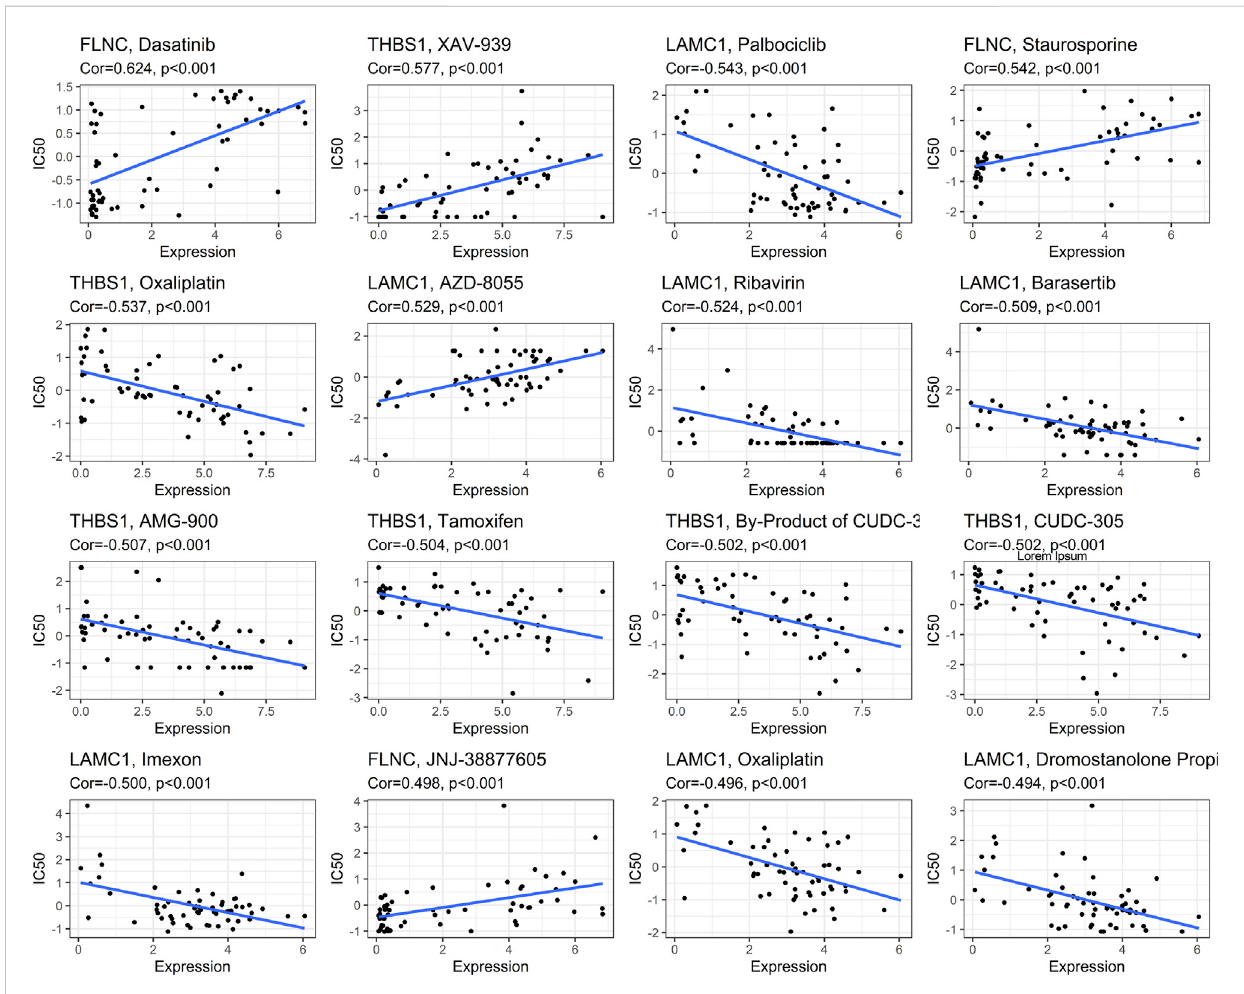
FIGURE 13 Correlations between focal adhesion-related genes expression and drug sensitivity. The fi gure shows the top 16 signi fi cant drug-gene pairs with signi fi cant correlation. X -axis: gene expression; y -axis: drug sensitivity Z